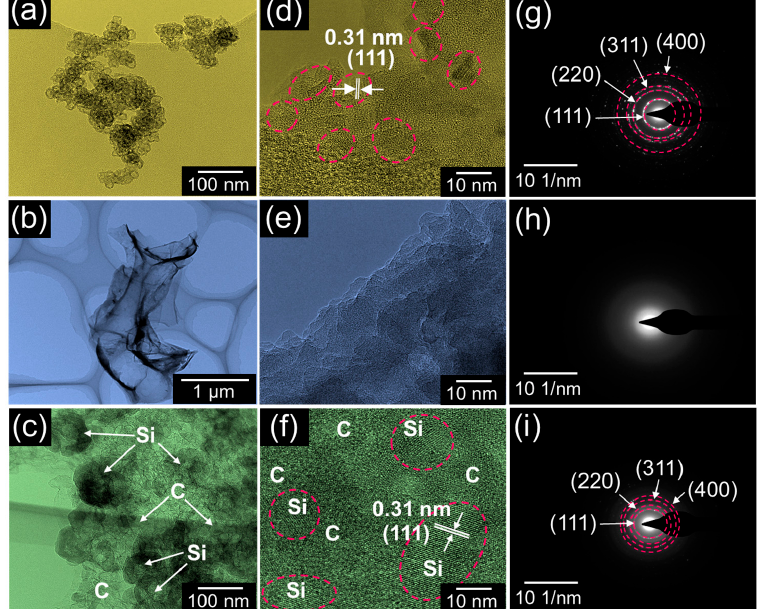
Figure 3. Bright-field transmission electron microscope (TEM) images of ( a ) nc-Si, ( b ) AC, and ( c ) AC < nc-Si > AC nanocomposites. High-resolution TEM images of ( d ) nc-Si, ( e ) AC, and ( f ) AC < nc-Si > AC